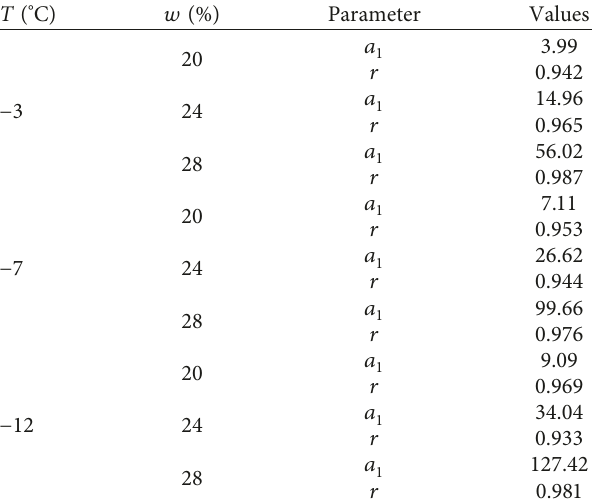
and the correlation coefficients r of the model 1 , a , and a . 1 2 3